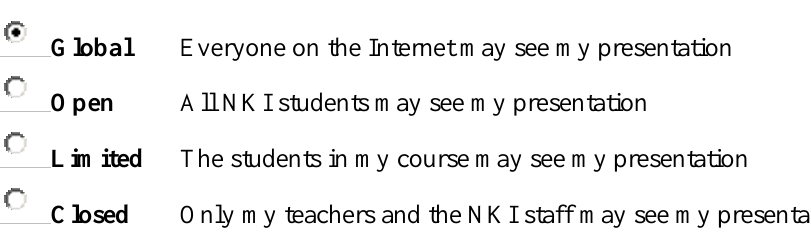
Table 2 Distribution of Visibility and Learning Partner Preferences